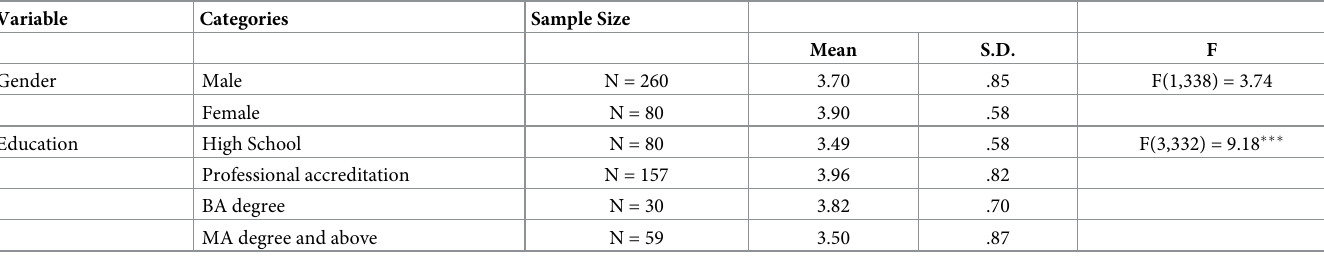
Table 2. Means and S.D. of perceived publicness across gender and education.